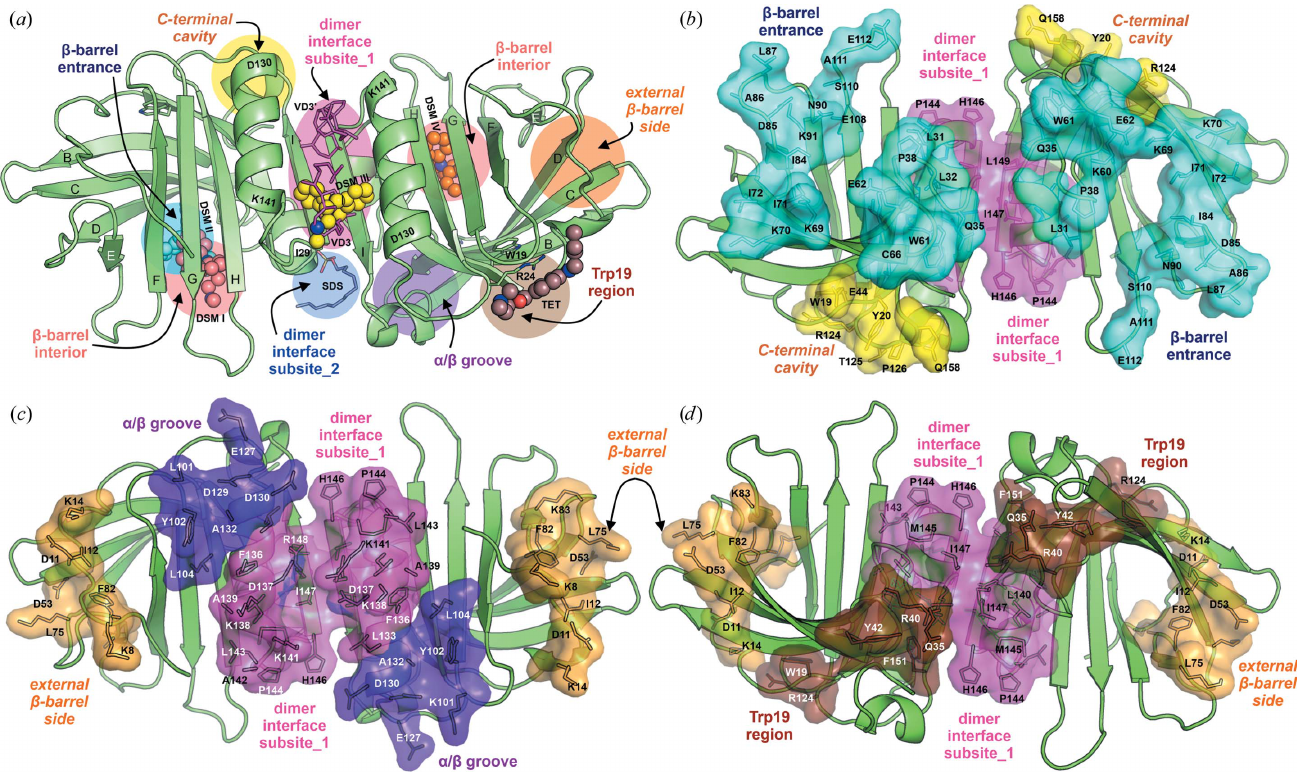
Figure 6 General classification of ligand-binding sites of the lactoglobulin dimer. ( a ) presents a superposition onto the BLG dimer frame of the ligands from the FAF–DSM structure, the BLG–VD3 complex (PDB entry 2gj5; VD3 and its symmetry-related copy VD3 0 ), the I56–TET complex (PDB entry 7b8f) and the BLG–SDS complex (PDB entry 7kp5). ( b ), ( c ) and ( d ) present ligand-binding sites located outside the (cid:2) -barrel (for the BLG molecule shown in different orientations). These sites are mapped onto the BLG dimer structure, with a detailed description given in Supplementary Table S3. Color codes: salmon, (cid:2) -barrel interior, primary site; yellow, site at the C-terminal cavity; cyan, (cid:2) -barrel entrance; violet, (cid:4) / (cid:2) groove; brown, Trp19 region; orange, external (cid:2) -barrel side; magenta, dimer interface, subsite_1; blue, dimer interface, subsite_2. Subsite_2 partially overlaps with the Trp19 region (brown) and (cid:4) / (cid:2) groove (violet) and was omitted from ( b ), ( c ) and ( d ) for